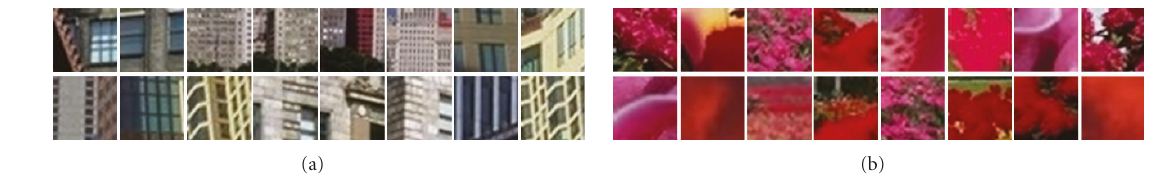
Figure 4: Examples of image blocks for “building” group (a) and “flower” group